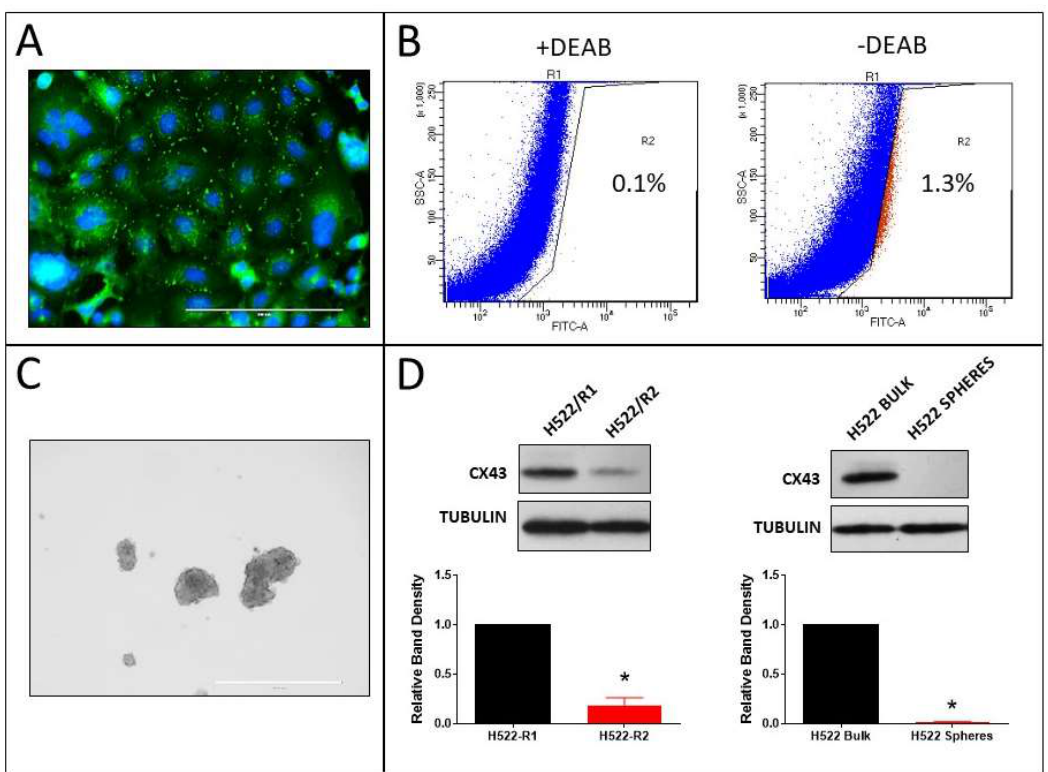
Figure 8. Expression of Cx43 in ALDH-positive cells and tumorspheres derived from H522 cells. ( A ) Cx43 immunostaining (scale bar: 200 µm); ( B ) dot plots of FACS-sorted ALDH-low (R1 pool) and ALDH-high (R2 pool) with and without DEAB (the percentages of R2 cells are shown on the plots); ( C ) H522 tumorspheres (scale bar: 1000 µm); and ( D ) Western blots of Cx43 in R1 (ALDH-low) and R2 (ALDH-high) populations (left blots) and bulk cells and tumorspheres (right blots); Cx43 band densities were normalized to tubulin loading control and to R1 or bulk cells (* p < 0.01 compared to R1 or bulk cells, one-sample t-test, mean ± S.D., n = 3 replicate experiments).